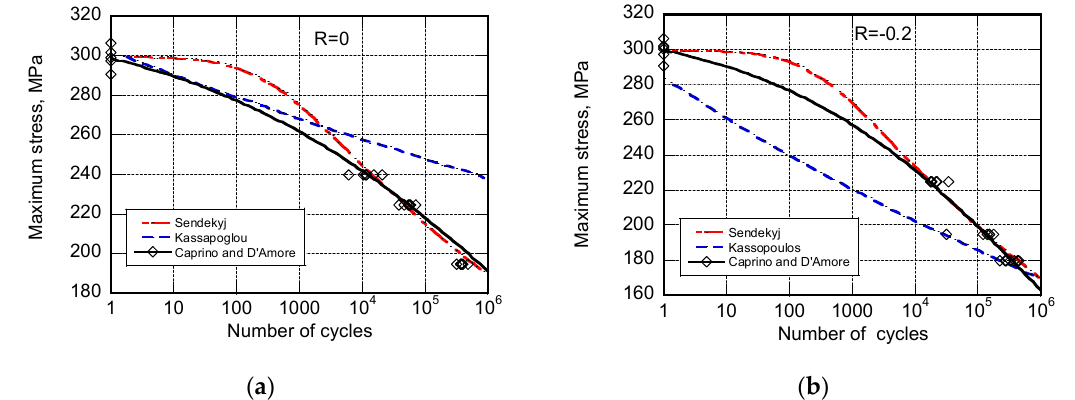
Figure 1. The experimental fatigue life data for AS4/E7K8 PW—10/80/10, OH, at R = 0 ( a ) and R = − 0.2 ( b ) and the predictions of different models as indicated in the inset.